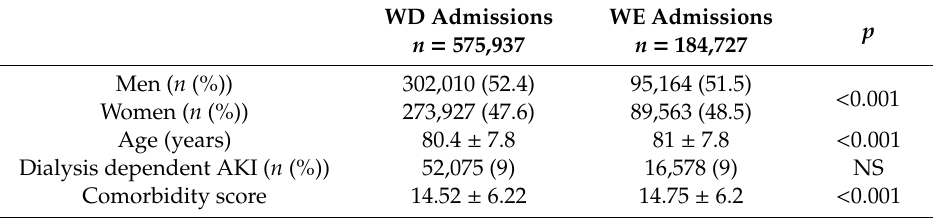
Table 4. Comparison between subjects admitted during weekdays (WD) or weekends